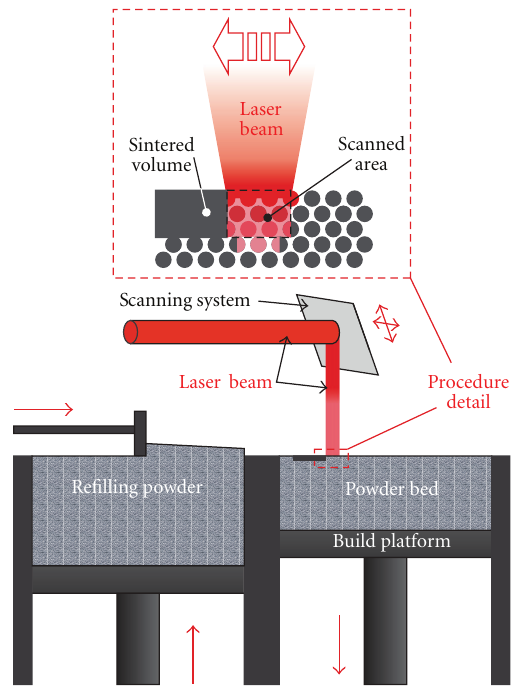
Figure 1: Selective laser sintering